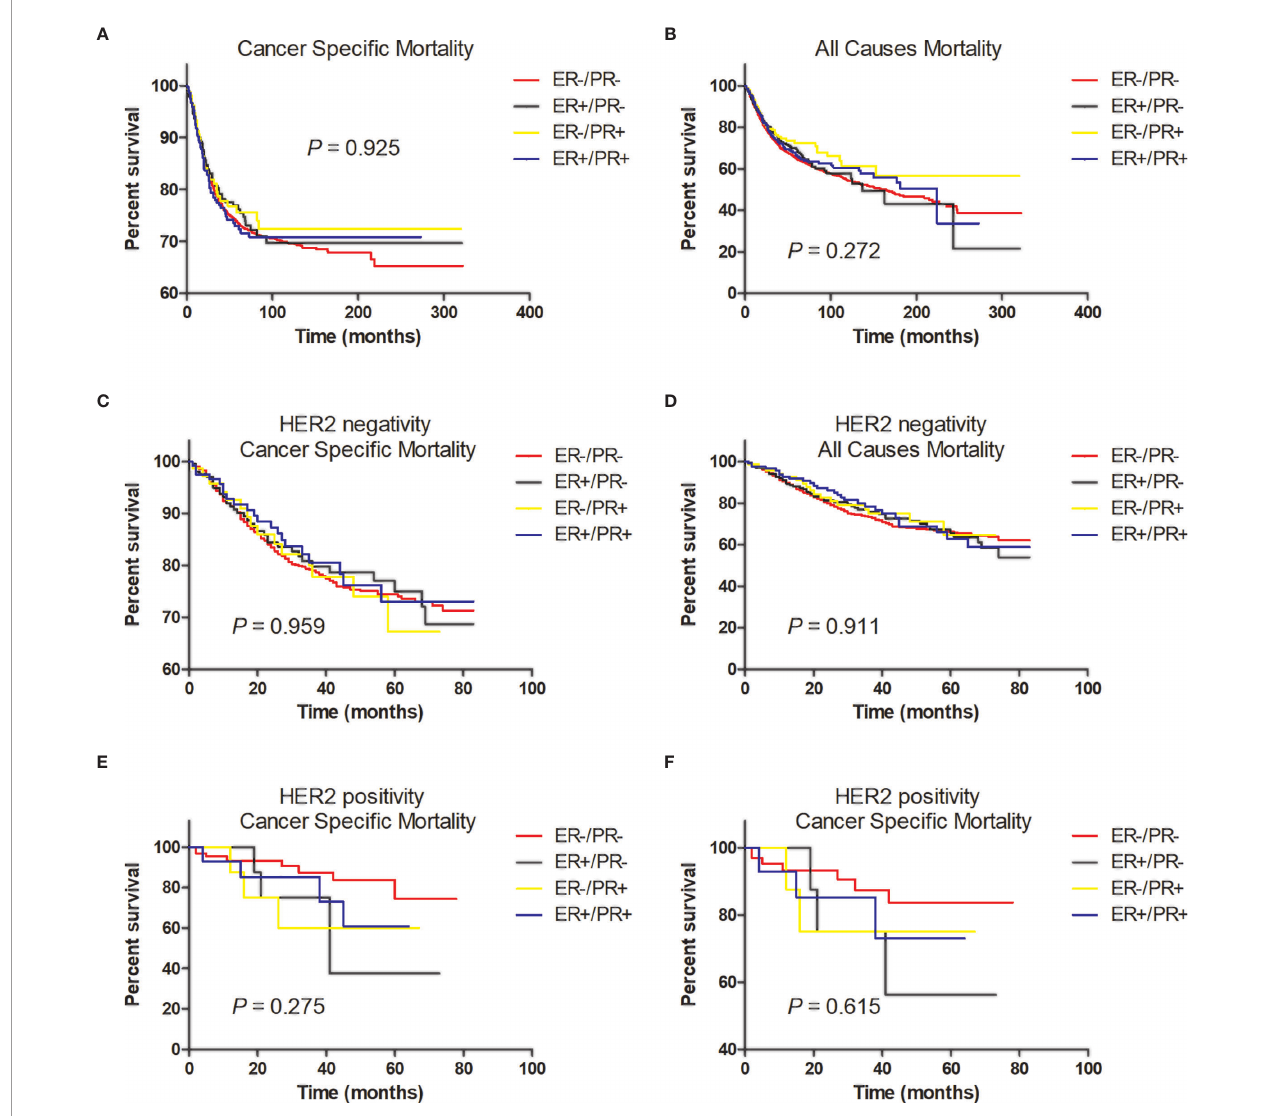
FIGURE 1 | Tumor survival based on hormone receptor status. (A) Breast cancer-speci fi c survival (BCSS) and (B) overall survival (OS) of all patients; (C) BCSS and (D) OS of patients with HER2-negative tumors; (E) BCSS and (F) OS of patients with HER2-positive